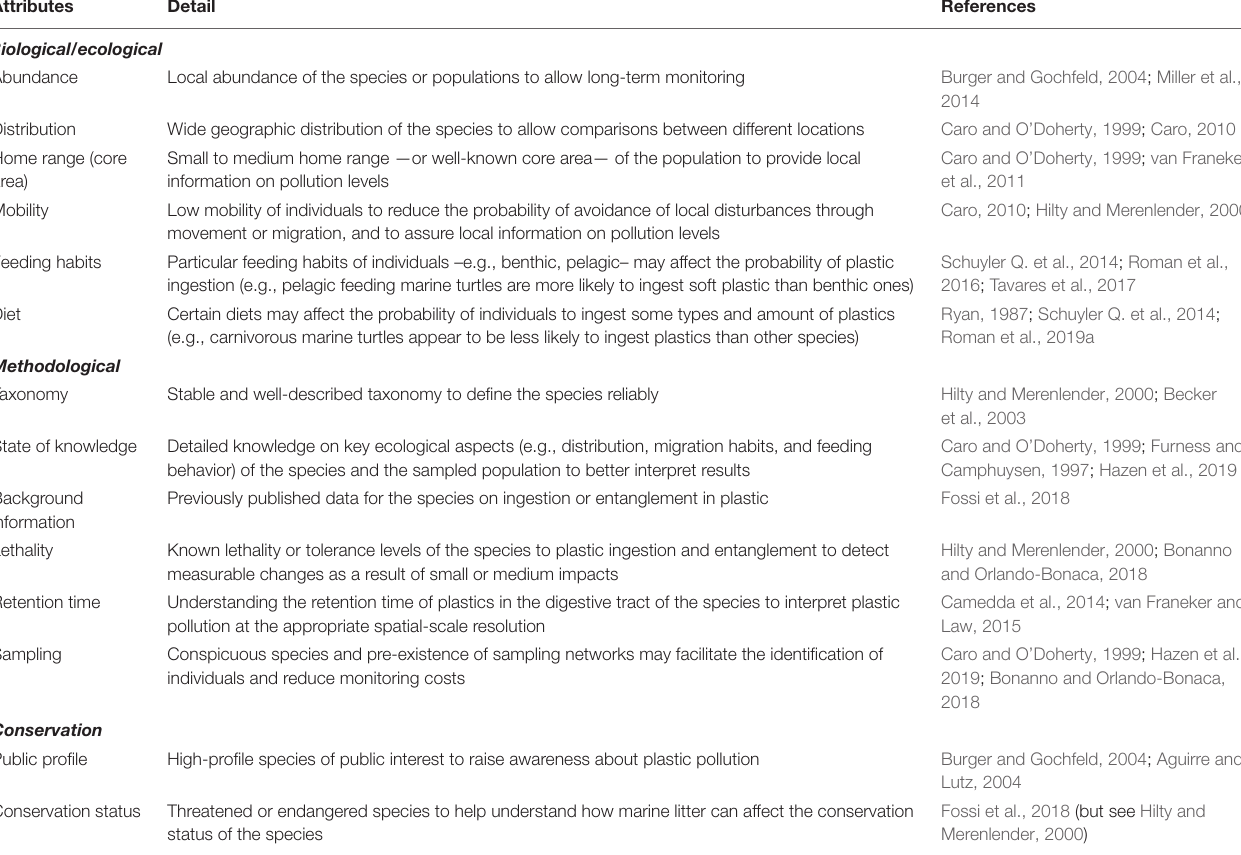
TABLE 1 | Biological/ecological, methodological, and conservation attributes of good indicator species of plastic pollution.